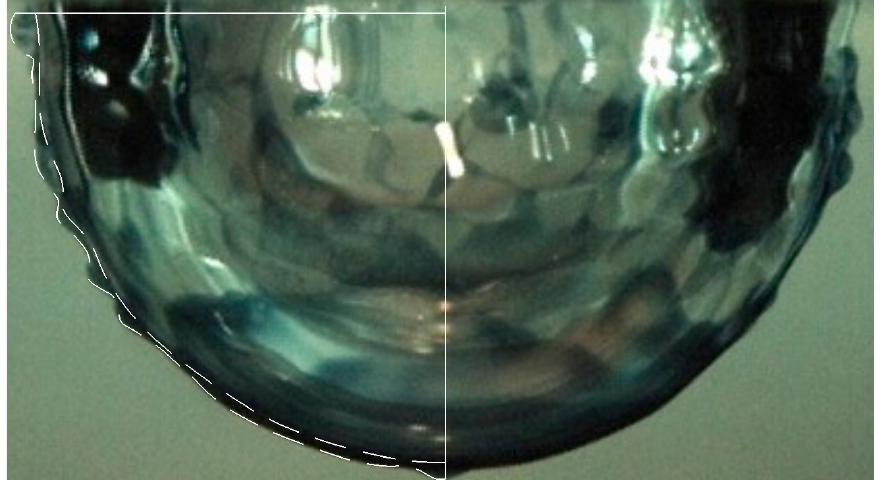
Figure 20. Spotty distribution of the drop substance over the surface of the wall and bottom of the cavity at t = 21.25 ms: a drop of ink solution diluted at ratio 1:100, with D = 4.3 mm and velocity U = 3.1 m/s merges with tap water, shooting rate 4000 fps.